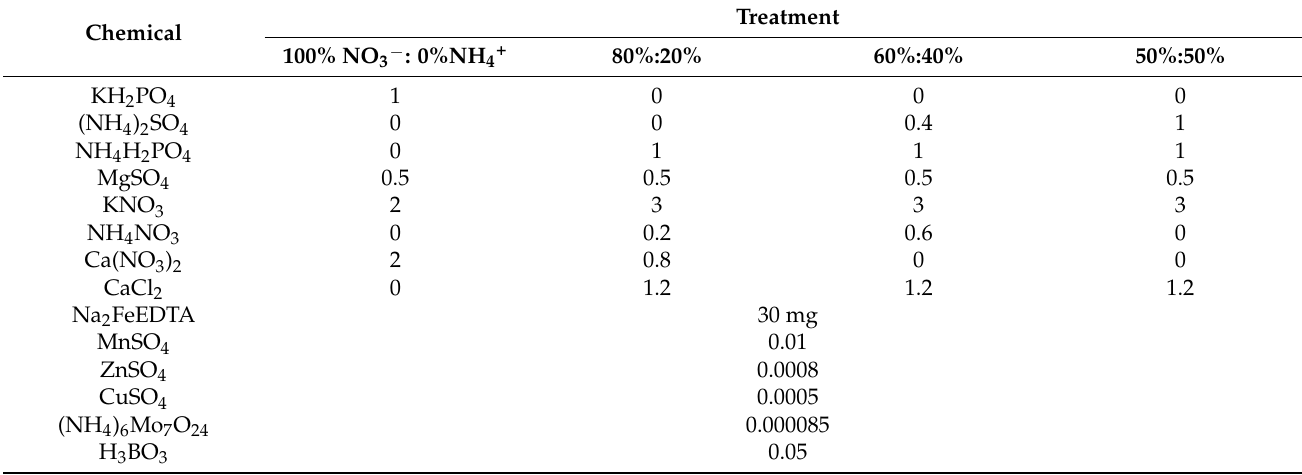
Table 1. The chemical composition of feed nutrient solutions of the four treatments. The micronutrients were consistent among the treatments, as well as the amounts of potassium, phosphate, magnesium, and total nitrogen. The numbers are the concentration measured in mmoL/L except when indicated in the table.